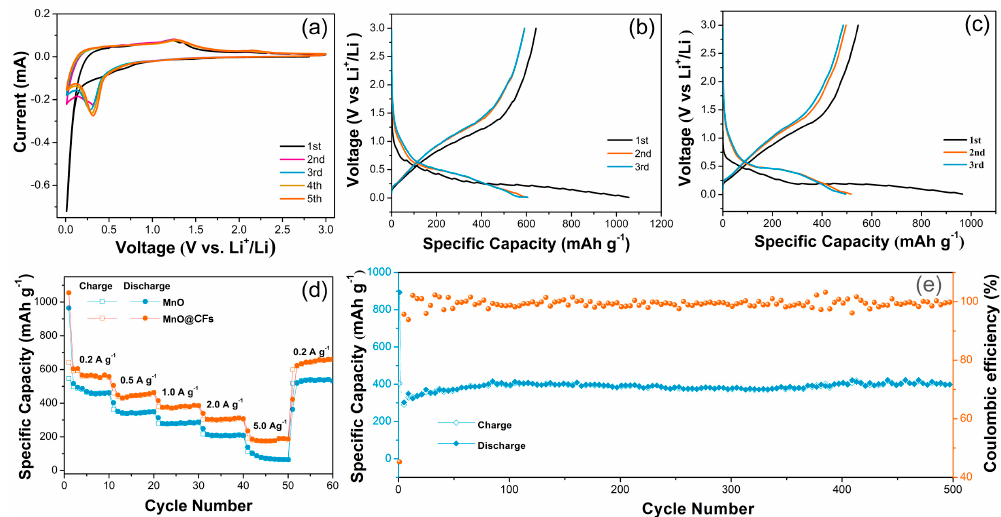
Figure 5. ( a ) Cyclic voltammetry (CV) of MnO@CFs electrode. Galvanostatic charge–discharge curves of ( b ) MnO@CFs and ( c ) MnO electrodes at 0.2 A g − 1 . ( d ) Rate performance of MnO@CFs and